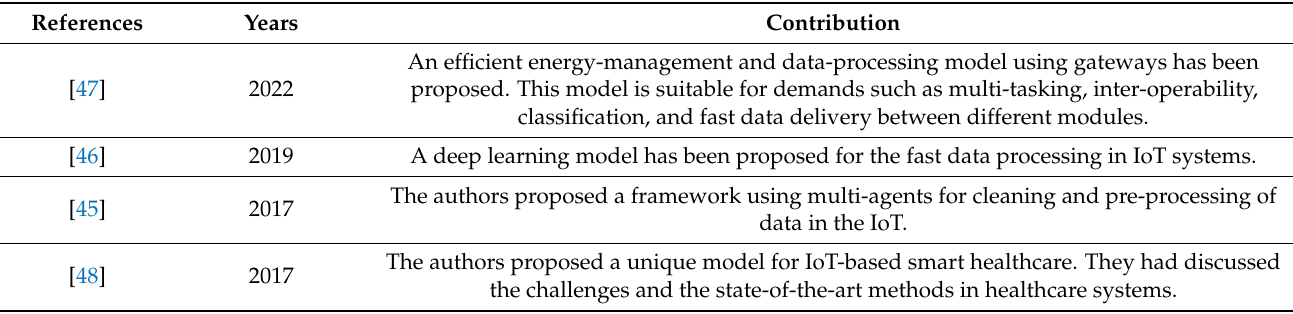
Table 2. The intelligent data processing methods in the